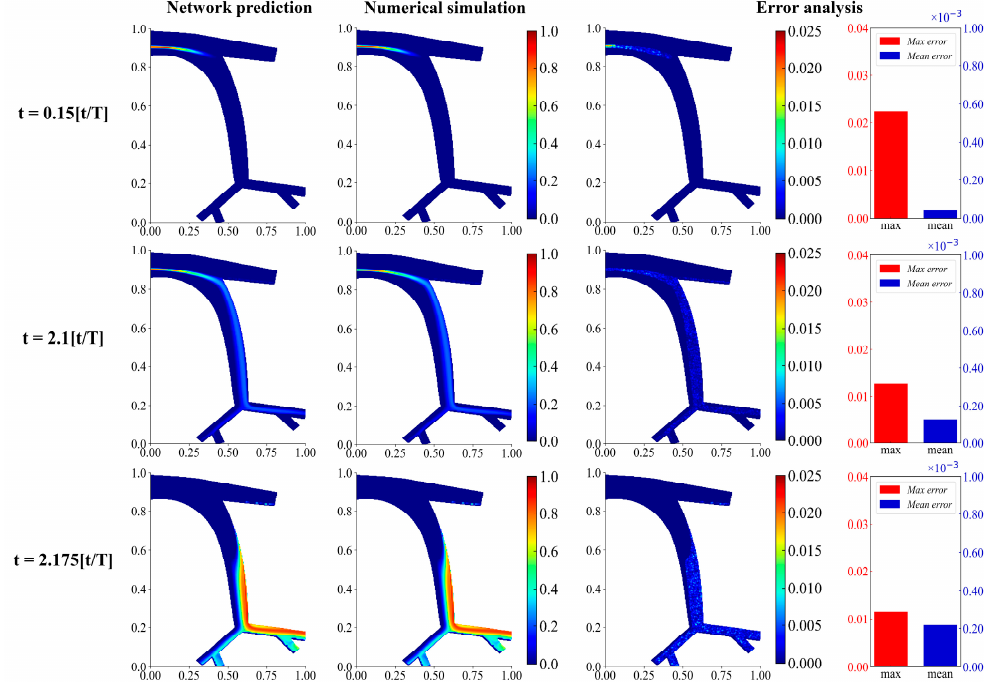
Figure 9. Drug concentration field and error distribution in the human hepatic artery at different times when the injection site is − 0.25 R away from the central axis of the blood vessel.